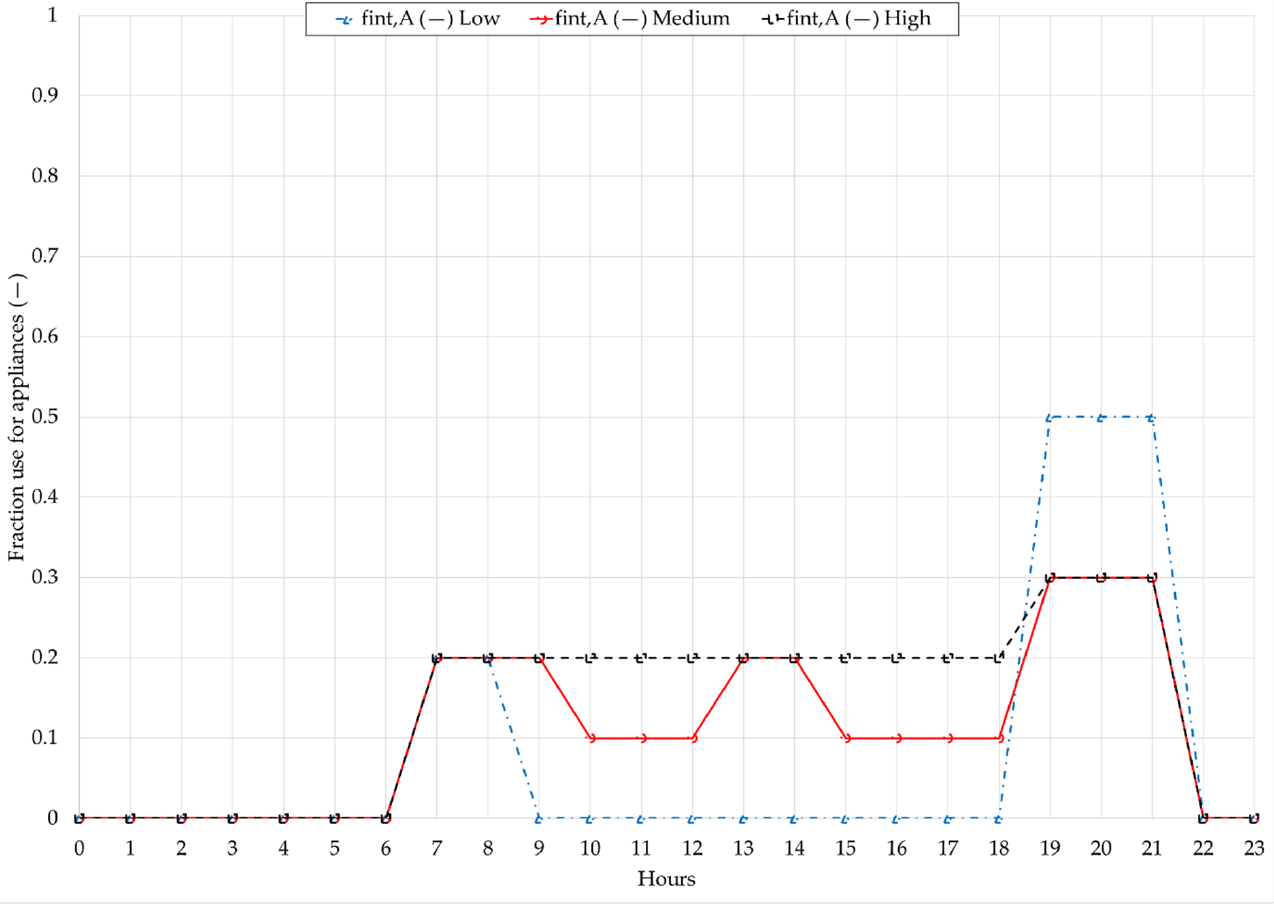
Figure 8. Fraction of lighting use for the different scenarios analysed (low, medium, and high).